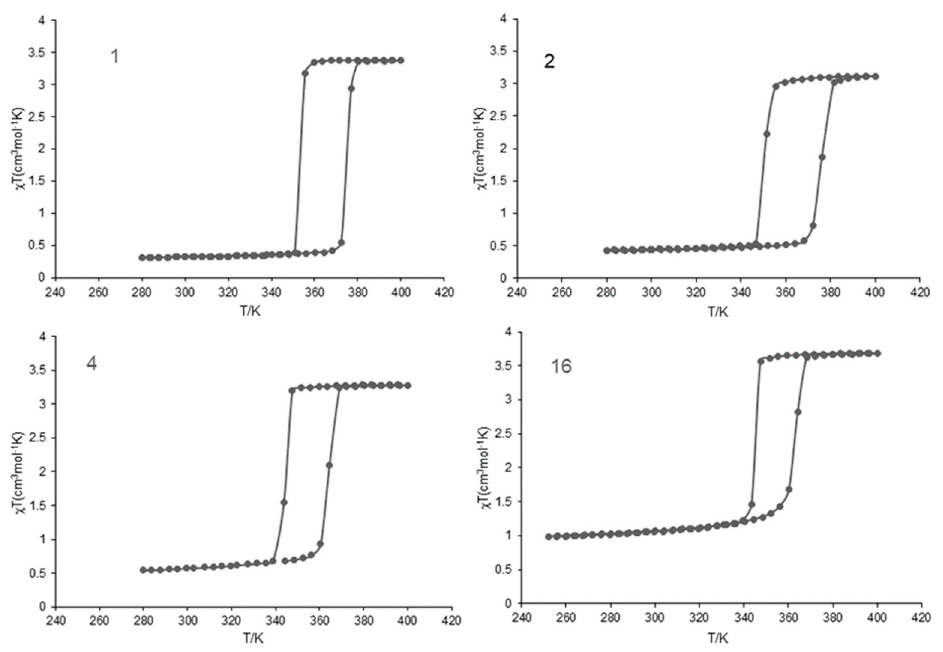
Figure 6. Variable temperature magnetic data for samples 1 (155 nm), 2 (108 nm), 4 (40 nm) and 16 (20 nm).